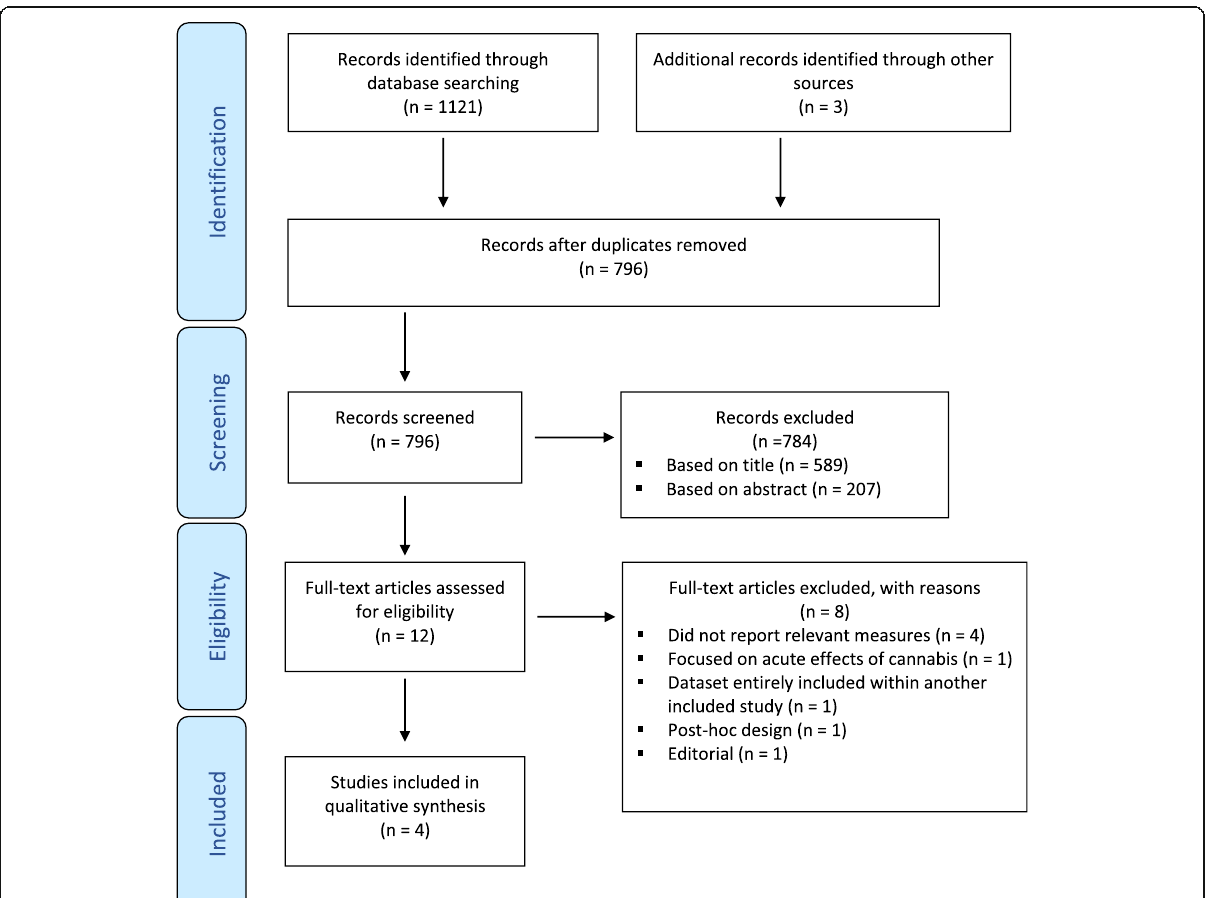
Fig. 1 PRISMA flowchart of systematic literature search . n = number of records, PRISMA = Preferred Reporting Items for Systematic Reviews and Meta-Analyses (Moher et al.